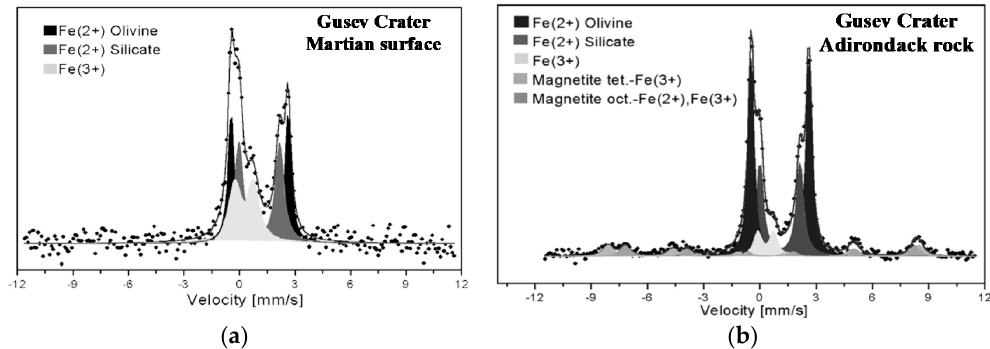
Figure 46. Mössbauer spectra from Gusev Crater, Mars: Martian surface ( a ) and Adirondack rock ( b ). T is in the range 200–280 K. Adapted from [138].